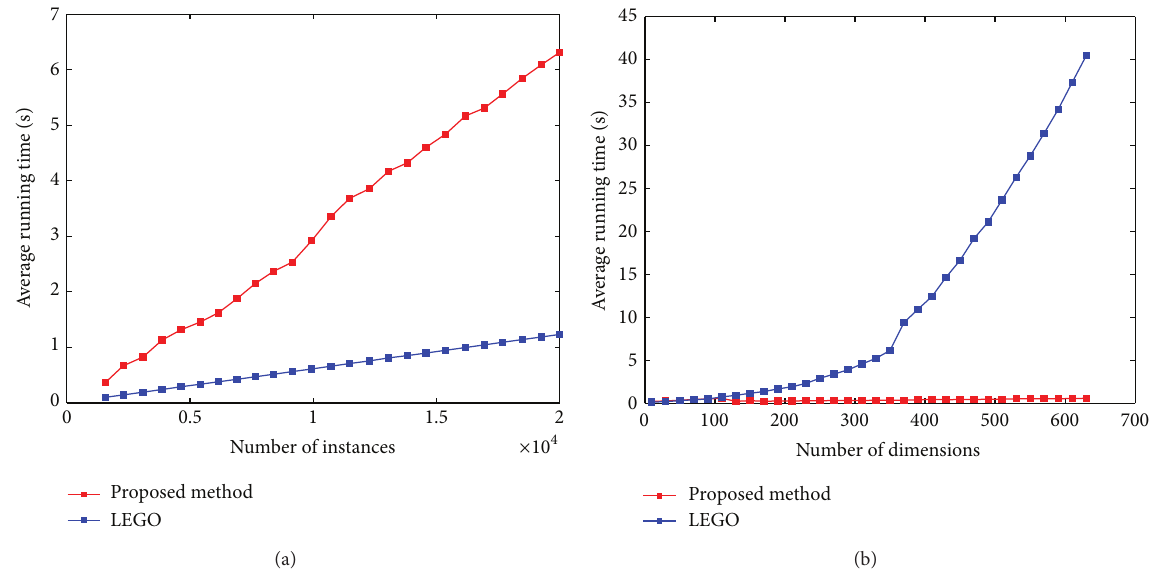
Figure 2: The relationship among number of instances, number of dimensions, and average running times. (a) The relationship between number of instances and average running times on data set “Letter-Recognition;” (b) the relationship between number of dimensions and average running times on data set “Mfeat.”